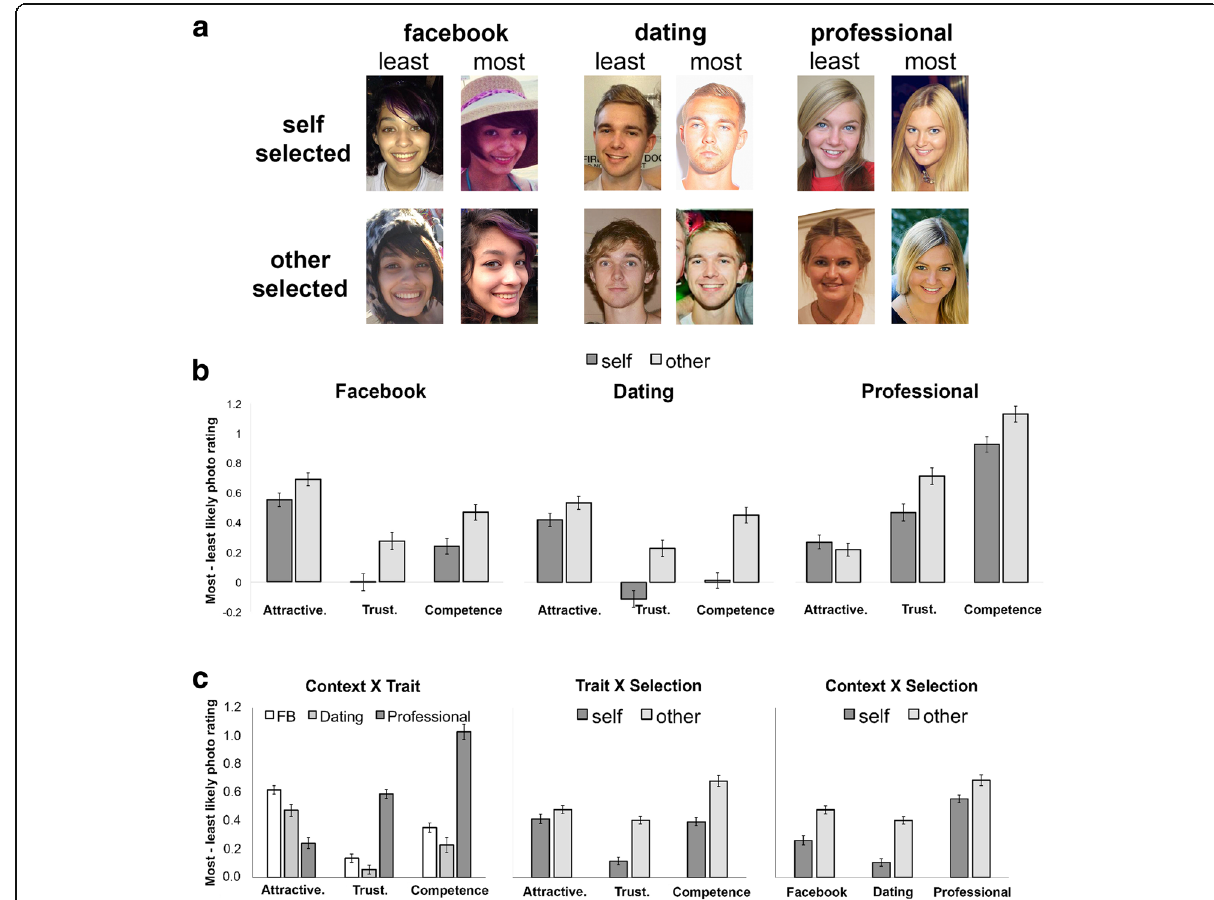
Fig. 3 a Examples of most and least likely image selections used in the Selection experiment. Images are used with permission and the full set of experimental materials are available online in Additional file 5. b Mean difference between trait impression ratings to photographs chosen as most and least likely profile pictures for each of three contexts. Positive values signify higher trait ratings for images selected as “ most likely ” profile images, again revealing more positive first impressions for images that were selected by an unfamiliar other ( light gray ) when compared to self-selections ( dark gray ). c Significant two-way interactions (see text for details of analysis). All error bars denote ±1 standard